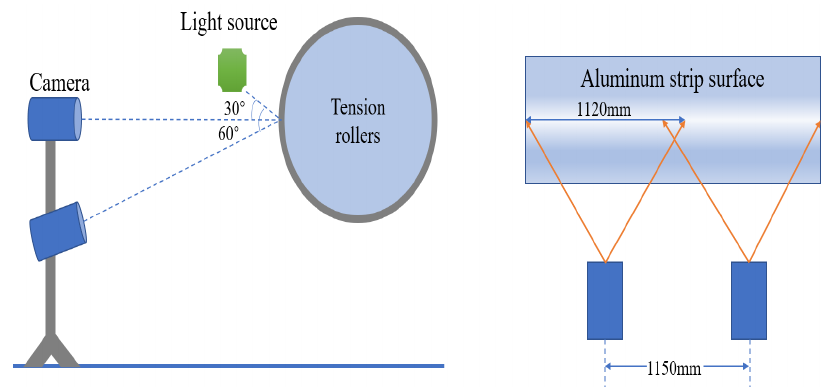
Figure 4. Surface inspection plan layout.